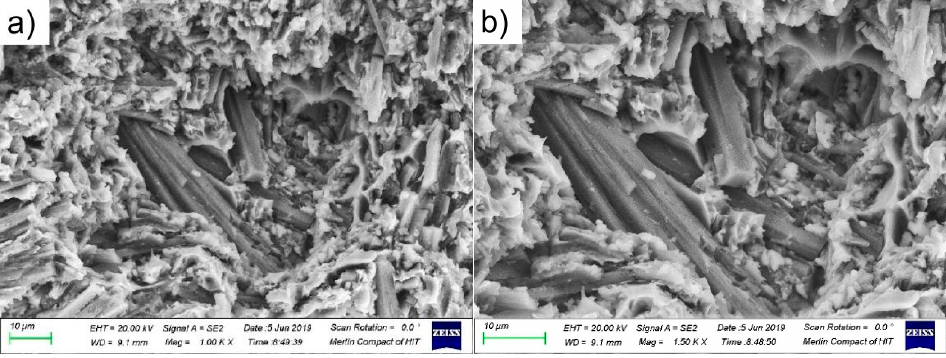
Figure 7. The high-temperature tensile fracture at 450 °C of the original squeeze casting: ( a ) 1000 times; ( b ) 1500 times. The high-temperature tensile fracture at 450 ◦ C of the aluminum matrix composite of extrusion is shown in Figure 8. A large number of pits can be observed, which were left by the whiskers pulled out from the matrix. The defects of the squeeze casting such as pores are reduced after sheathed extrusion, and the whiskers are oriented along the extrusion direction. The whiskers in the original squeeze casting are randomly distributed, rotate in the direction of tension during the tensile deformation and are easy to crack in this process. However, the randomly distributed whiskers will bear the shear force in the tensile direction, which increases the strength of aluminum matrix composites. Therefore, the tensile strength is affected by two aspects of whisker orientation. Different from the original squeeze casting, the orientation of the whiskers in the extrusion are uniformly